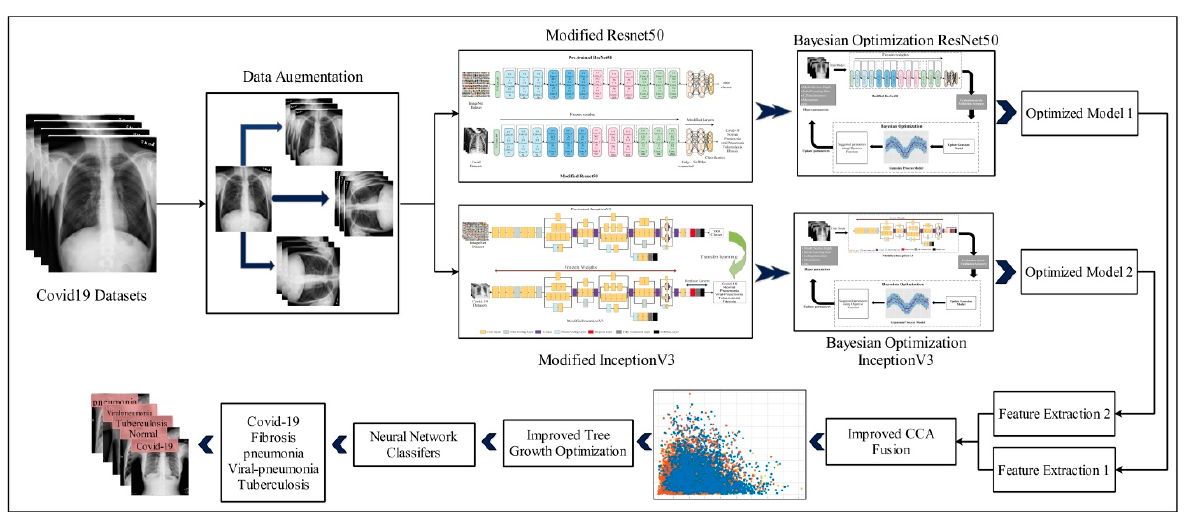
Figure 1. Proposed methodology for diagnosing COVID-19 using Bayesian optimization and im- proved tree growth optimization.